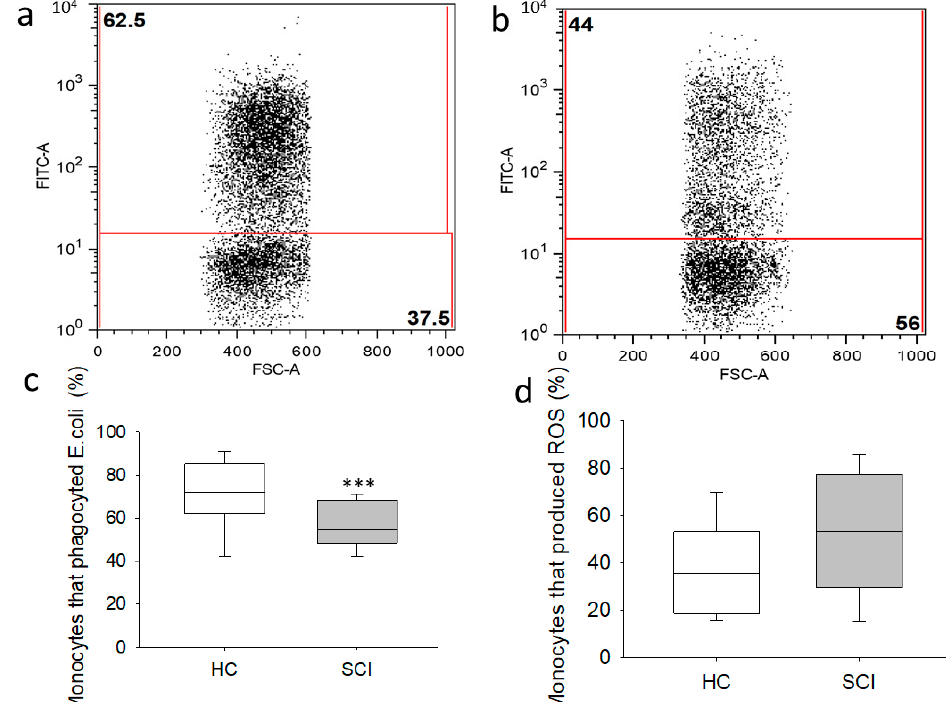
Figure 6. Phagocytosis and ROS production by circulating monocytes from chronic SCI patients. Representative analysis of monocytes that phagocytosed E. coli in a healthy control: ( a ) and a chronic SCI patient; ( b ). The percentages of peripheral blood monocytes that phagocytosed E. coli; ( c ) and that produced ROS; ( d ) in chronic SCI patients (gray box) and healthy controls (white box) are shown. *** Significant difference between patients and healthy controls ( p < 0.001).